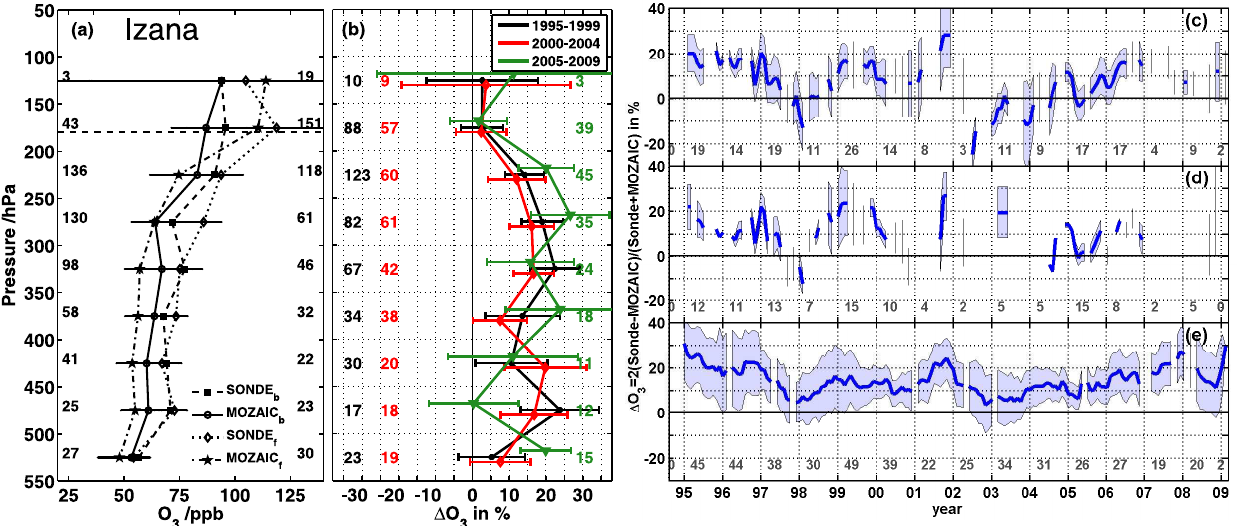
Fig. 13. Comparison of ozonesonde and MOZAIC ozone measurements. As for Fig. 3, but for Izaña. SP sondes operated with 1.0% electrolyte are used for the entire period.